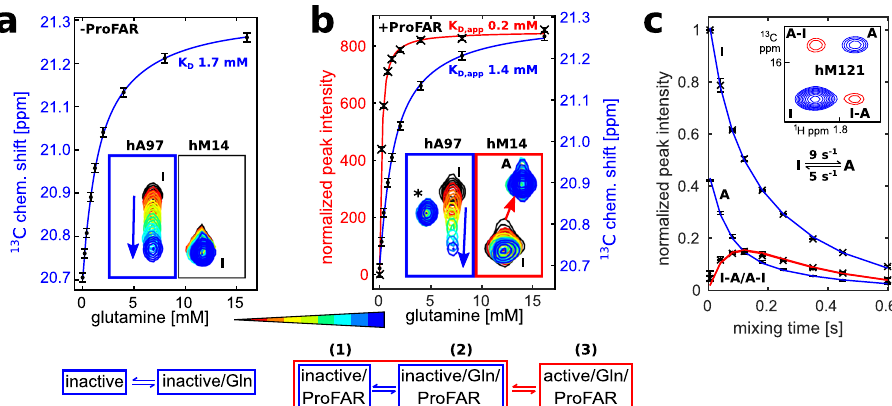
Fig. 3 The HisFH inactive and active conformations are in a dynamic equilibrium. a Gln titration to HisFH – hC84S in the absence of ProFAR. Insets show closeups of methyl TROSY spectra for hA97 and hM14, which report on Gln binding (hA97) and formation of the active conformation (hM14). Gln binding to the inactive conformation (I) is fast on the NMR timescale and is followed based on the chemical shift of hA97 (blue arrow). The 13 C chemical shift of hA97 is plotted against the Gln concentration (black dots) and a fi t (blue line) to a two-state binding model is shown. The error-bars correspond to the spectral resolution. b Gln titration to HisFH – hC84S in the presence of ProFAR. The saturation of the HisF substrate binding site does not affect Gln binding to the inactive conformation (blue box). Concurrent with Gln binding to the inactive conformation the formation of the active conformation takes place. This conformational change is slow on the NMR timescale and is monitored based on the intensity of the hM14 signal (red box). With increasing Gln concentration the resonances of the inactive conformation decrease, while the signals of the active conformation (A) increase (black crosses). Note that the hA97 resonance intensity decreases with increasing Gln concentration due to the depletion of the inactive conformation. The signal of the active conformation of hA97 cannot be analyzed as it overlaps with other signals. The data are fi tted to a three-state model (red and blue lines) that includes the formation of the active state. The error-bars correspond to the resolution (hA97) and noise level (hM14) of the spectra. The signal marked with an asterisk that appears next to hA97 belongs to the active conformation of hV100. The error-bars correspond to the spectral resolution. c Longitudinal ZZ-exchange experiments for HisFH – hC84S in the presence of ImGP/Gln reveal that the inactive and active conformations interconvert on the ms-time scale. The inset shows hM121 in the inactive (blue, labeled I) and active conformation (blue, labeled A) for a mixing time of 80 ms. The exchange peaks that originate from the interconversion between the two conformations are shown in red. Data are presented as mean values ± 1 standard deviation ( n = 8 spectra). Source data are provided as a Source data fi le for all panels.